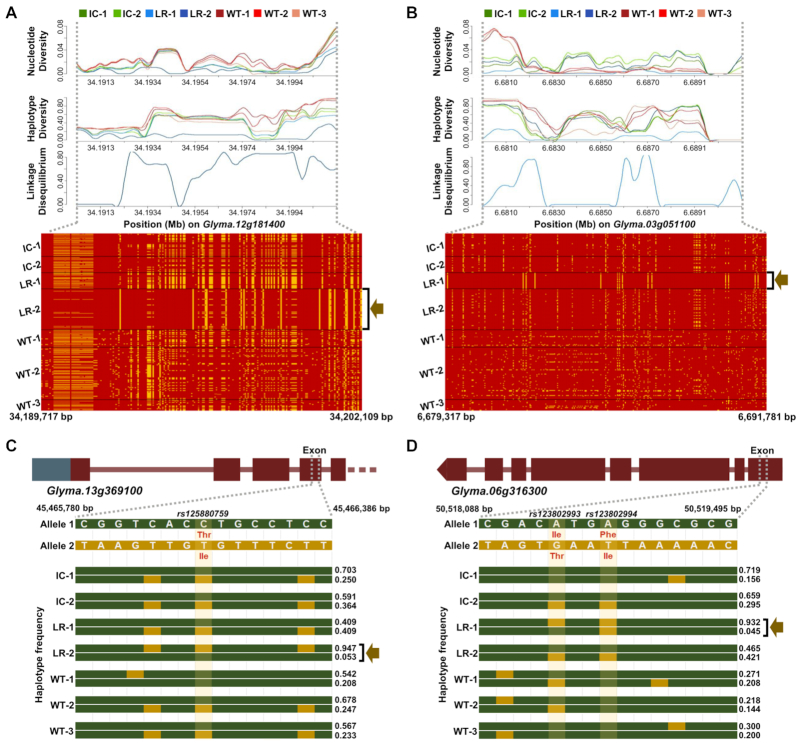
Selection signatures for the LR-1 and LR-2 subgroups. A, B, Patterns of the nucleotide diversity, haplotype diversity, and linkage disequilibrium (top) and the degree of haplotype sharing among all subgroups (bottom) in Glyma.03g051100 and Glyma.12g181400. The Glyma.03g051100 and Glyma.12g181400 genes are located at 6,684,296–6,686,809 bp on chromosome 3 and at 34,193,664–34,197,110 bp on chromosome 12, respectively. All 7 subgroup lines are shown for the nucleotide and haplotype diversities. For clarity of the subgroup lines, only the LR-1 and LR-2 subgroup lines are shown for the linkage disequilibrium. Detailed illustrations of the 3 patterns are provided in Supplementary Figs S16a–c and S18a–c. The plots for the degree of haplotype sharing are shown for all variants in the entire regions of 2 genes, and the major and minor alleles of each variant are marked red and yellow, respectively. C, D, Gene structures and haplotype frequencies for regions containing 2 and 1 missense variants in Glyma.06g316300 and Glyma.13g369100, respectively. The gene structures are illustrated on the top, and regions containing the missense variant and its surrounding 14 variants are shown beneath them. Reference and alternative alleles (Alleles 1 and 2) are marked green and yellow, and missense variants are highlighted in light yellow. The missense variants of the Glyma.06g316300 and Glyma.13g369100 genes are located at 50,518,313 and 50,518,392 bp on chromosome 6 (p.Ile34Thr on rs123802993 and p.Phe8Ile on rs123802994) and at 45,466,067 bp on chromosome 13 (p.Thr218Ile on rs125880759), respectively. The haplotype structures for those regions are depicted below the gene structures, with haplotype frequencies shown to the right. Only the top 2 haplotype frequencies are displayed for each subgroup due to illustration constraints. Information regarding all haplotype frequencies is provided in Additional File 5.